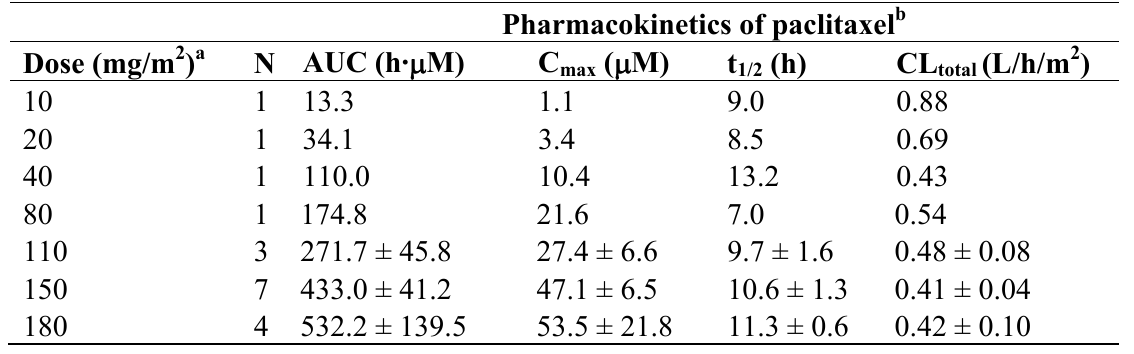
Table 9. Results of Phase I pharmacokinetic study and toxicity of NK105 in cancer patients [27]. Pharmacokinetics of NK105 Pharmacokinetics of paclitaxel